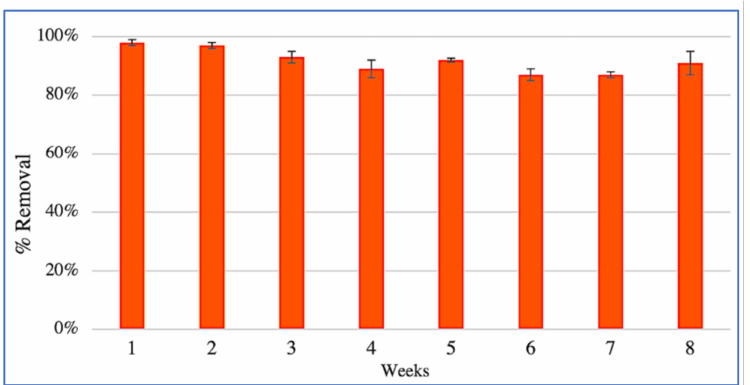
Figure 2. Removal percentage (%, mean and standard deviation, n = 3) of PCP in CWs, irrigated for eight weeks with Ribeira de Joane water doped with 100 µ g · L − 1 of PCP per week.